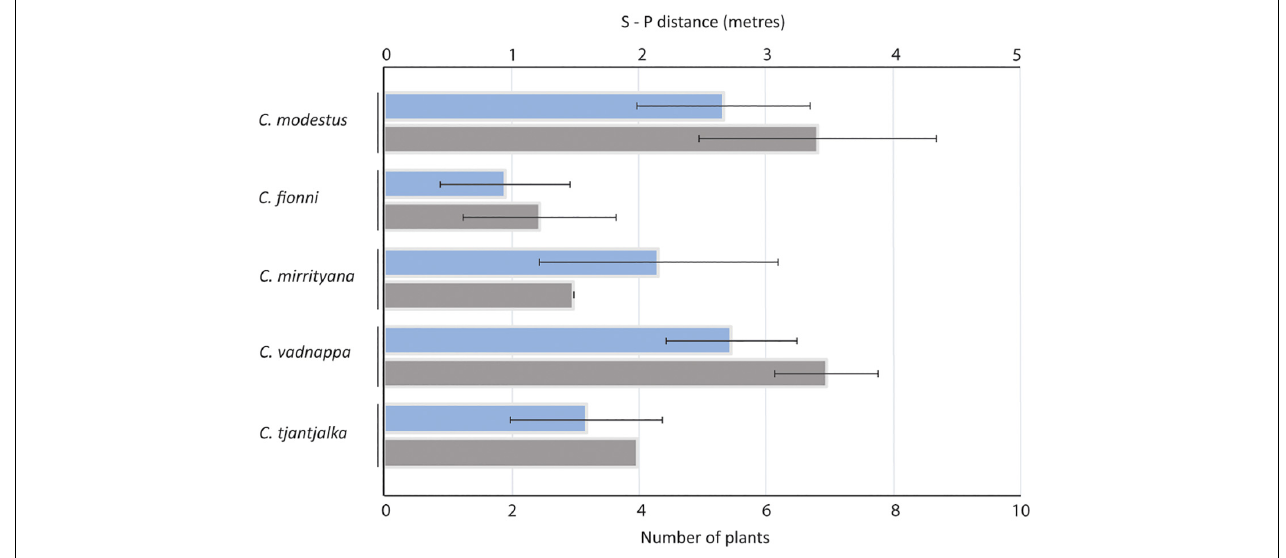
FIGURE 6 | Average signaler-plant distance (blue) and average number of relevant plants (gray) at the signaling habitats for the five study species. Error bars represent standard deviation.